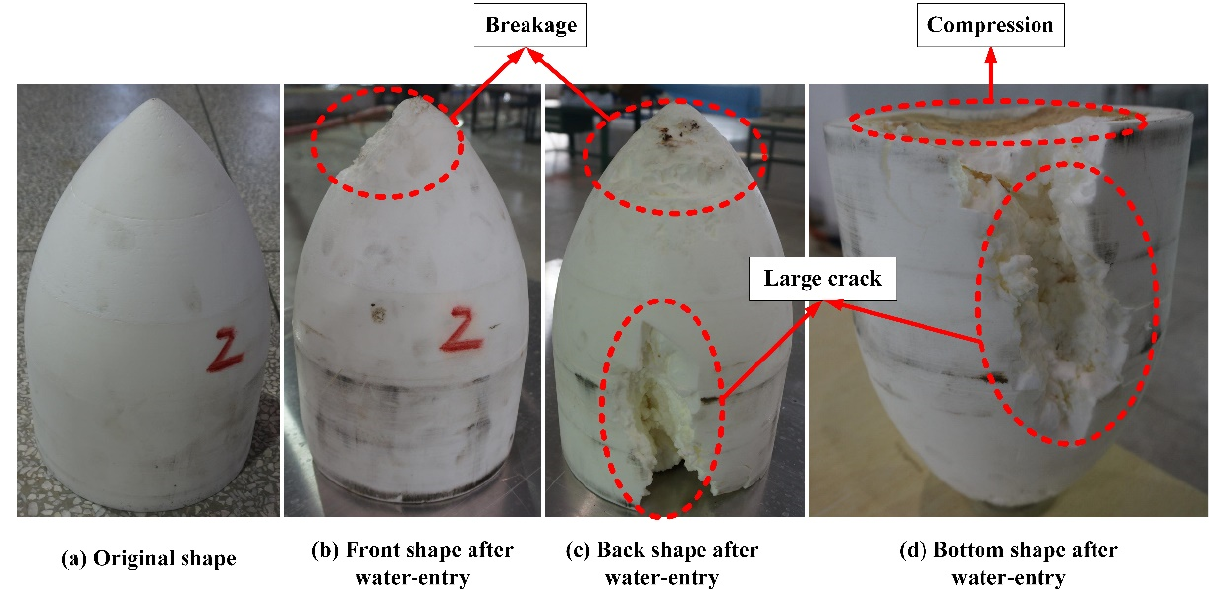
Figure 15. Comparison of No. 2 head cap before and after water entry.